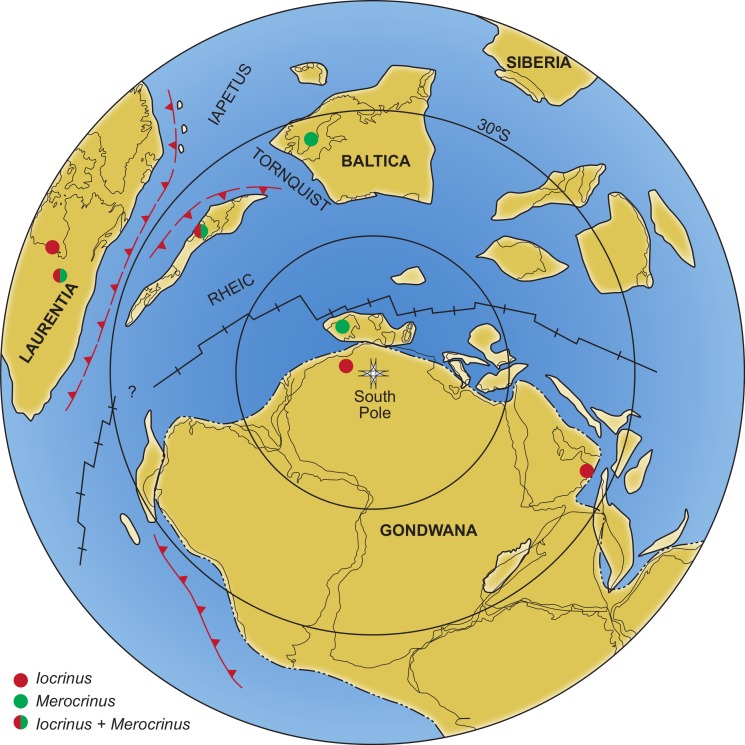
Distribution of the major paleocontinents during the Middle Ordovician, showing the known geographical distribution of Iocrinus and Merocrinus.Locality markers indicate the presence of a taxon on a palaeocontinent; multiple localities are not noted on a single palaeocontinent. Modified from Cocks & Torsvik (2006).